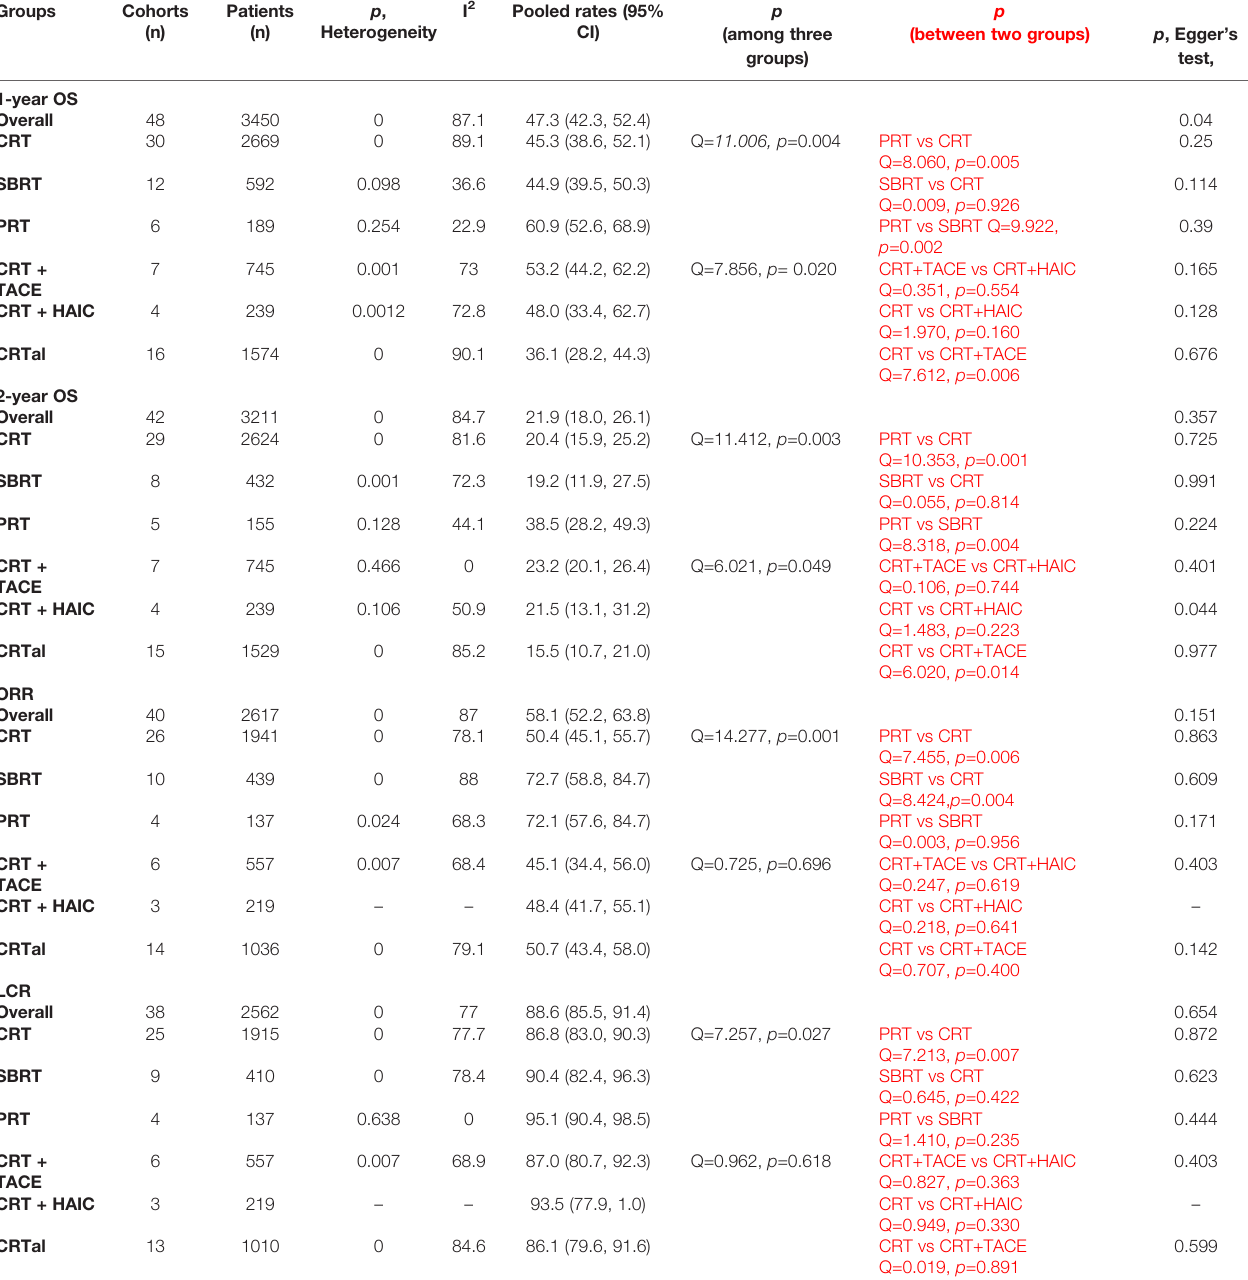
TABLE 4 | Comparison of pooled outcomes among